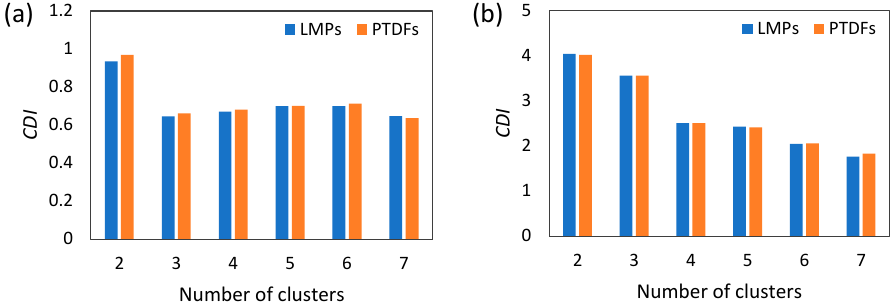
Figure 11. Clustering Dispersion Indicator ( CDI ) computed considering LMP s ( a ) and PTDF s ( b ) as “common ground”.